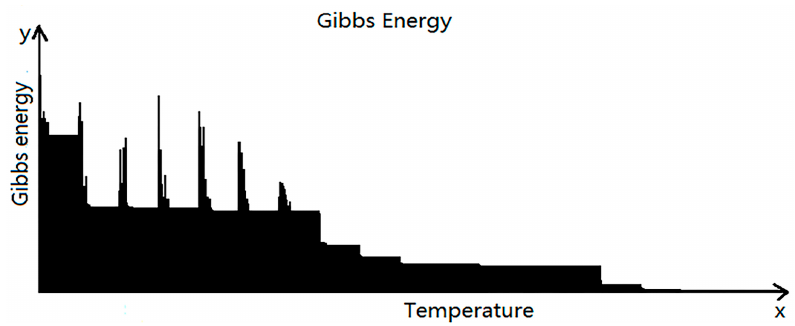
Figure 9. Decreasing of Gibbs energy.